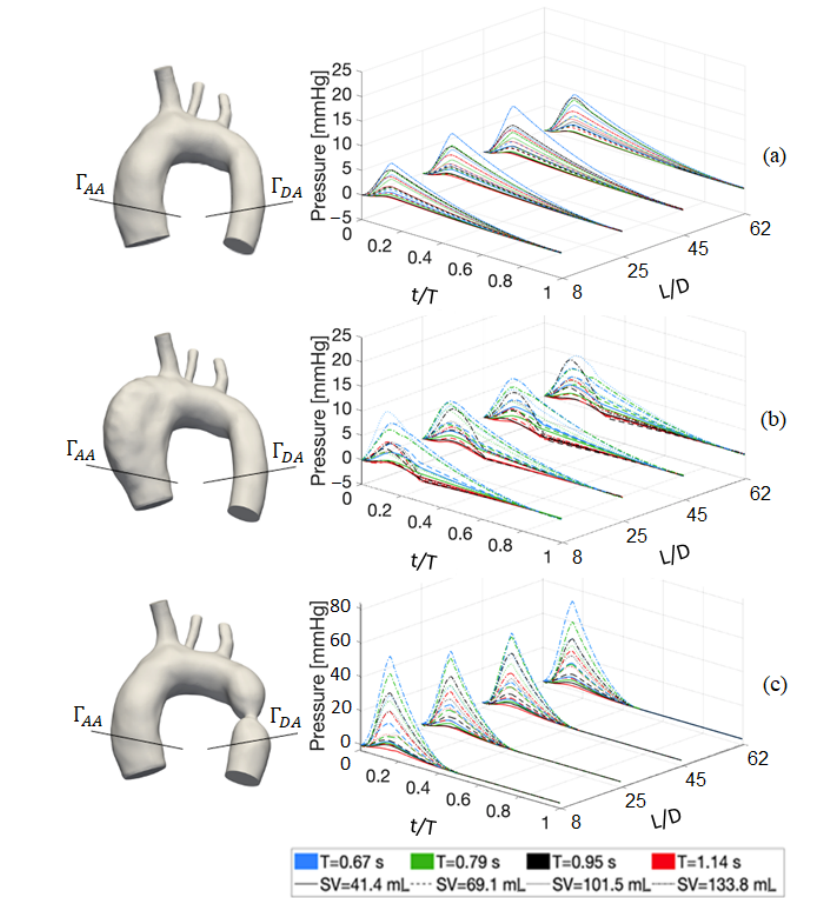
Figure 12. Effect of SV , T , and L / D on the deterministic ∆ p waveforms between Γ AA and Γ DA : ( a ) healthy aorta, ( b ) aorta with aneurysm, and ( c ) aorta with